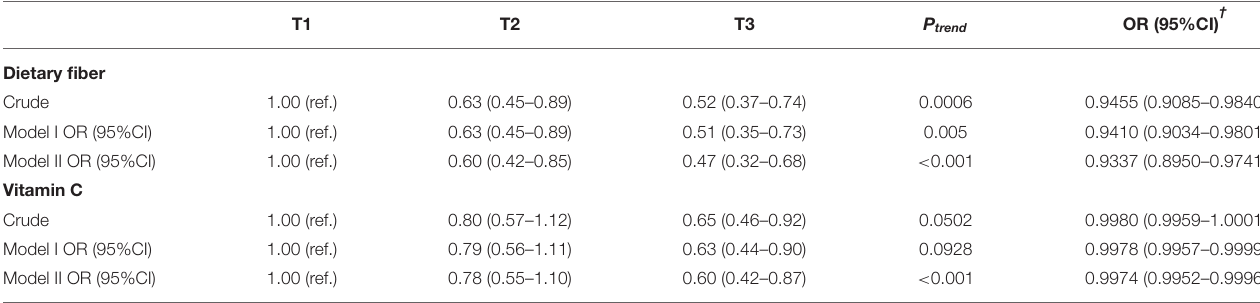
TABLE 3 | Association between dietary fiber and vitamin C intake and oral cancer by logistic